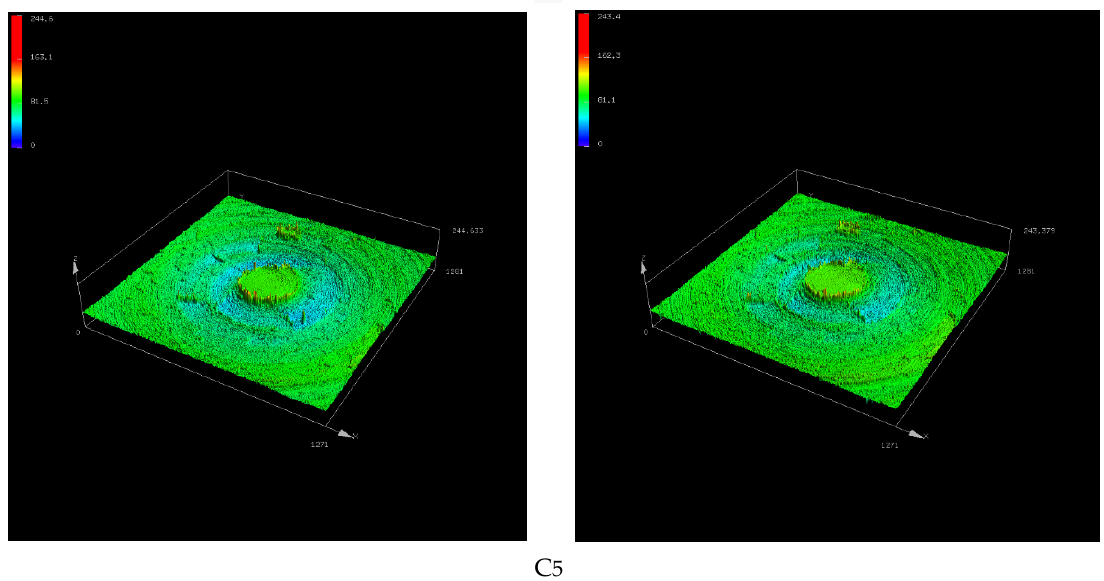
Figure 11. Three-dimensional morphology of the metal surface before and after friction.